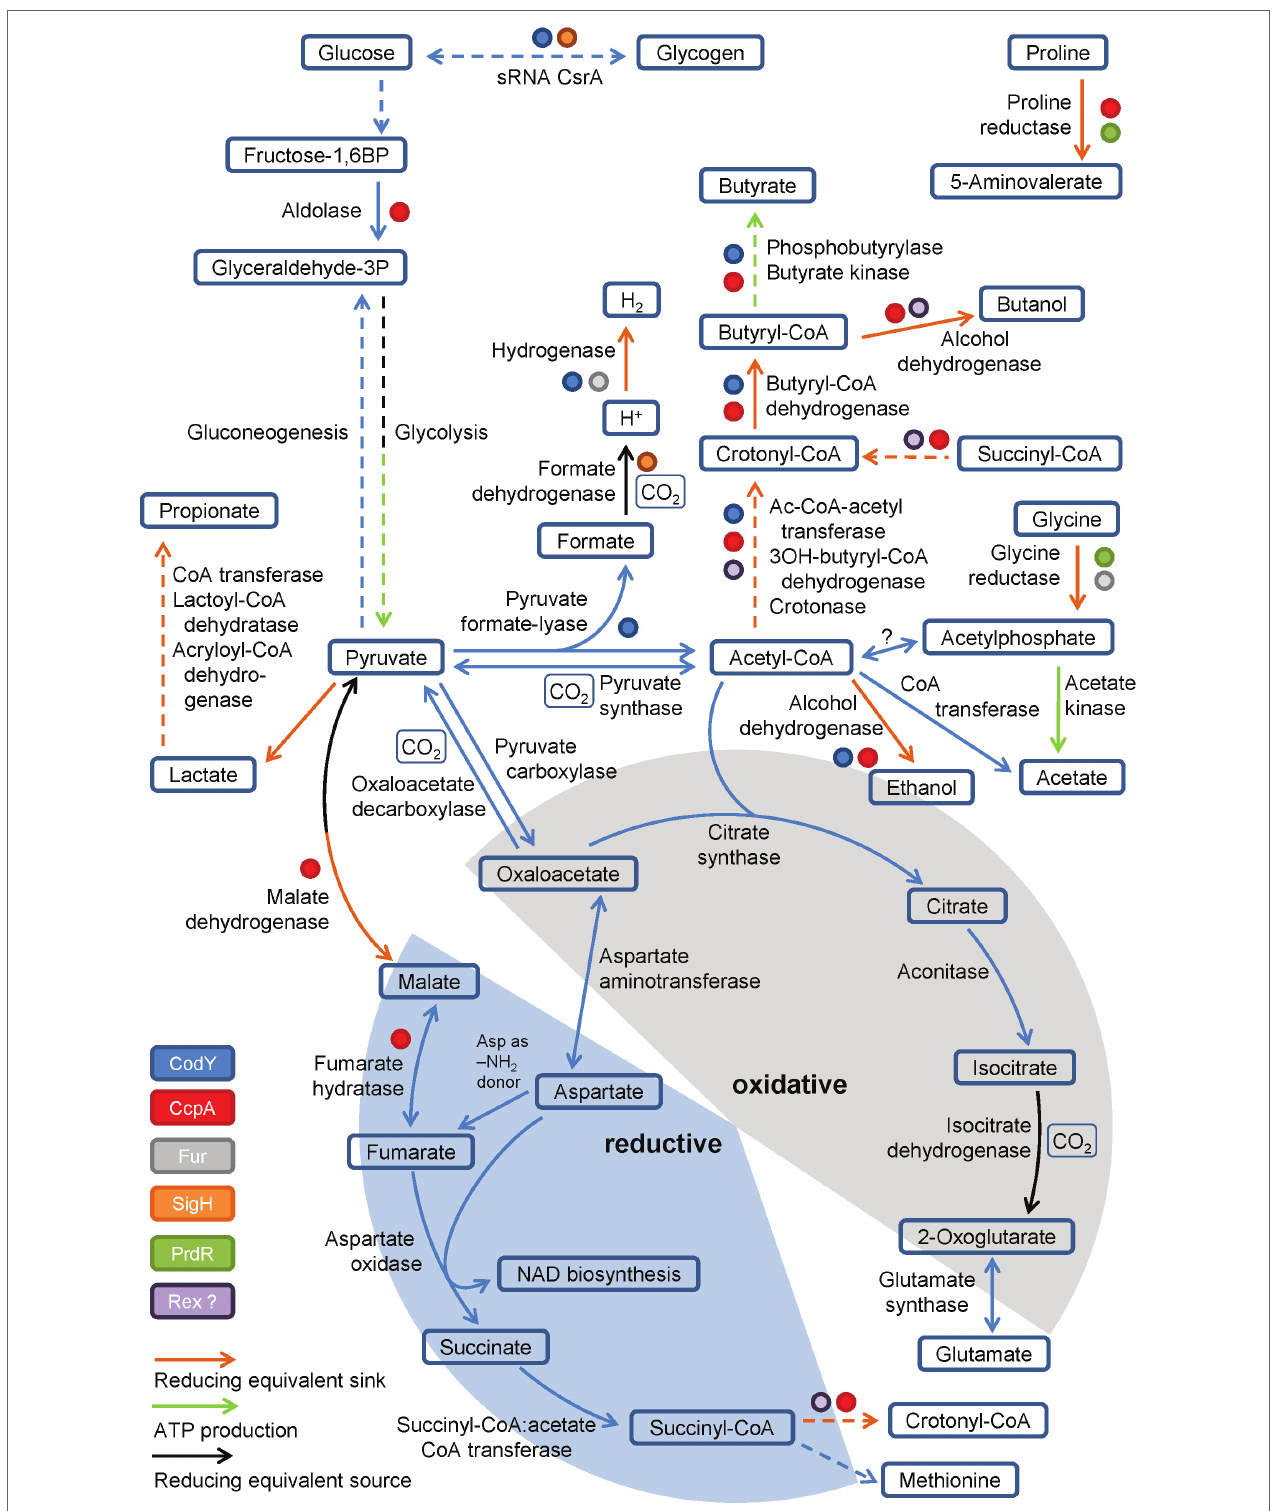
FIGURE 2 | Glycolysis, gluconeogenesis, the fragmented TCA cycle, anaplerotic reactions and global regulators involved in metabolism. Schematic overview of the glycolysis, gluconeogenesis, the fragmented TCA cycle showing the oxidative and the reductive pathway, including anaplerotic reactions as well as global regulators controlling the central metabolism. Global regulators are marked by colored dots, ATP producing and reducing equivalent consuming/producing reactions are marked by colored arrows. (BP: bisphosphate, P: phosphate, Ac: Acetyl, -OH: -hydroxy). Dashed arrows represent multiple